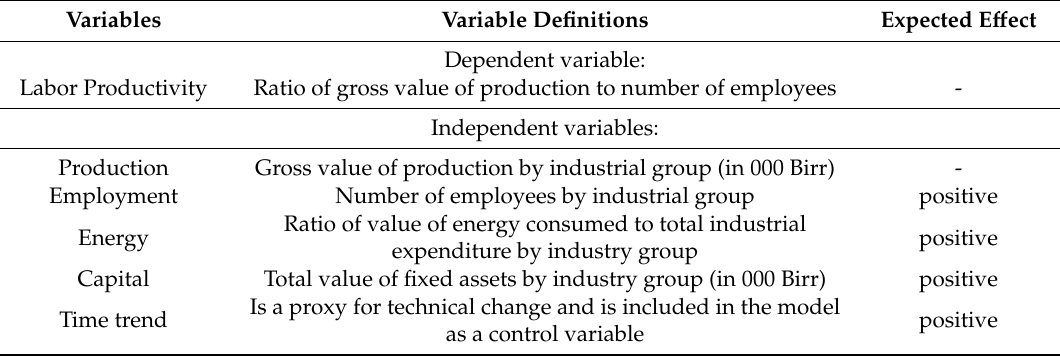
Table 2. List of variables, expected level of significance, and coe ffi cient